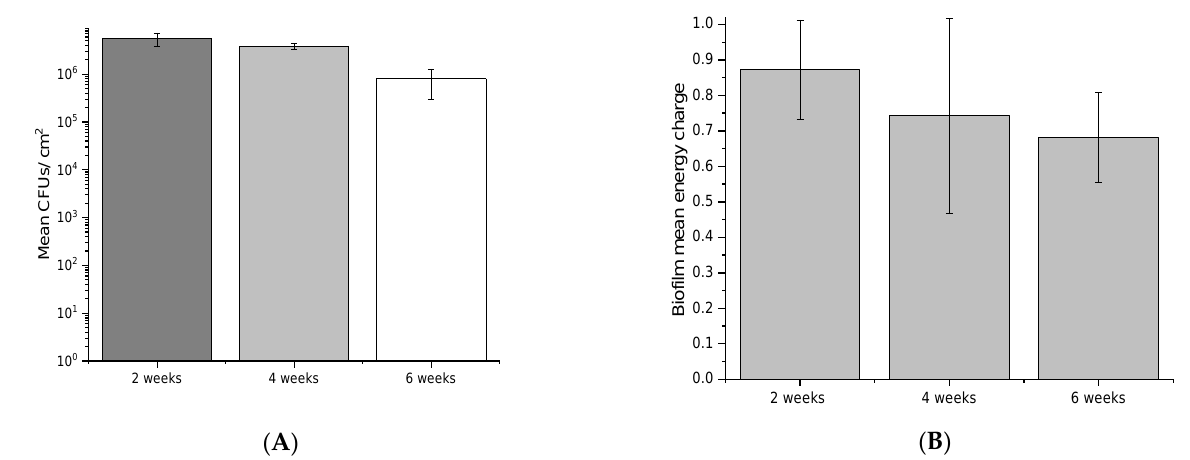
Figure 6. Mean CFUs ( A ) and the pooled energy charge ( B ) of biofilms at 2, 4, and 6 weeks. Error bars represent the standard deviation of 2 experimental and 3 technical replicates.